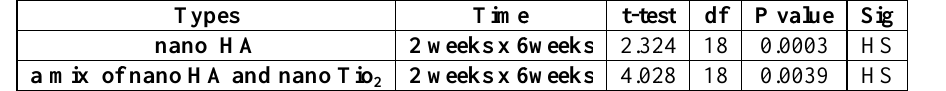
Table2:t –test for equality of means of torque value for nano T a mix of n